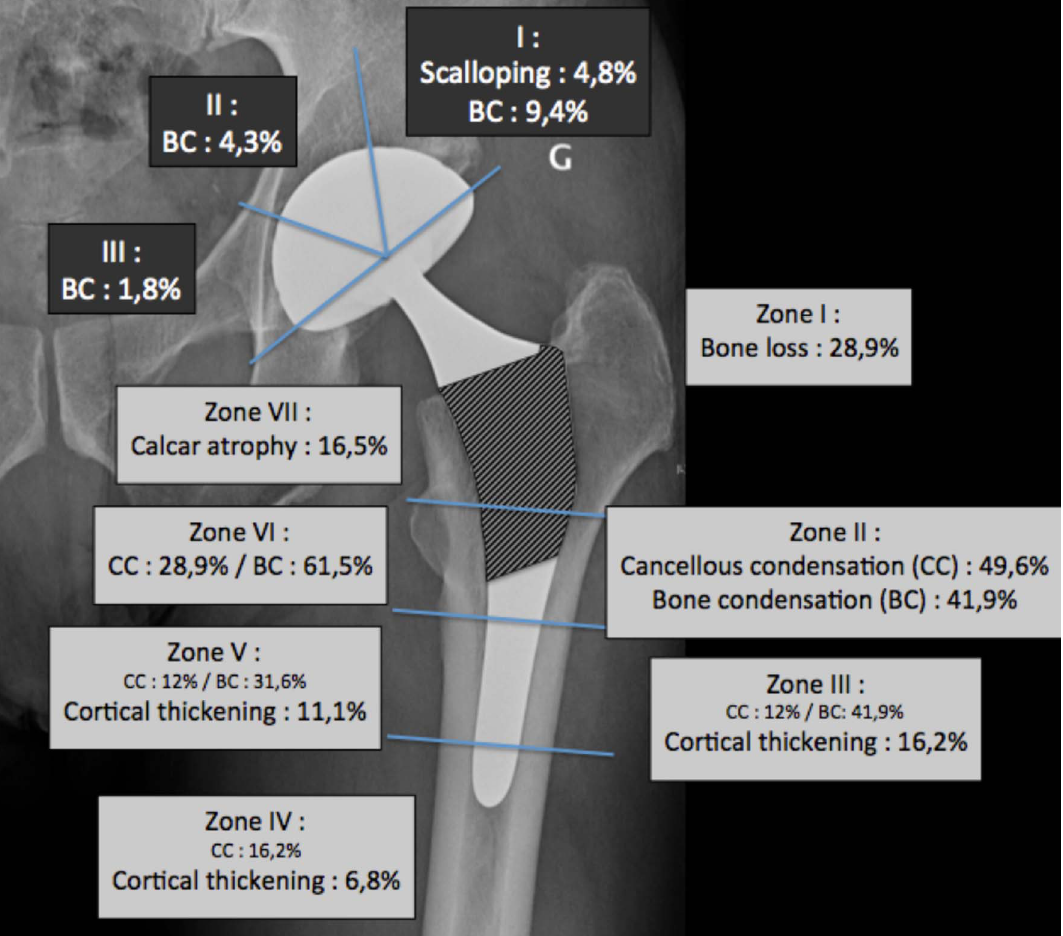
Figure 5. Radiological patterns at bone-implant interface. The cross-hatched area of the stem corresponds to the hydroxyapatite-coated